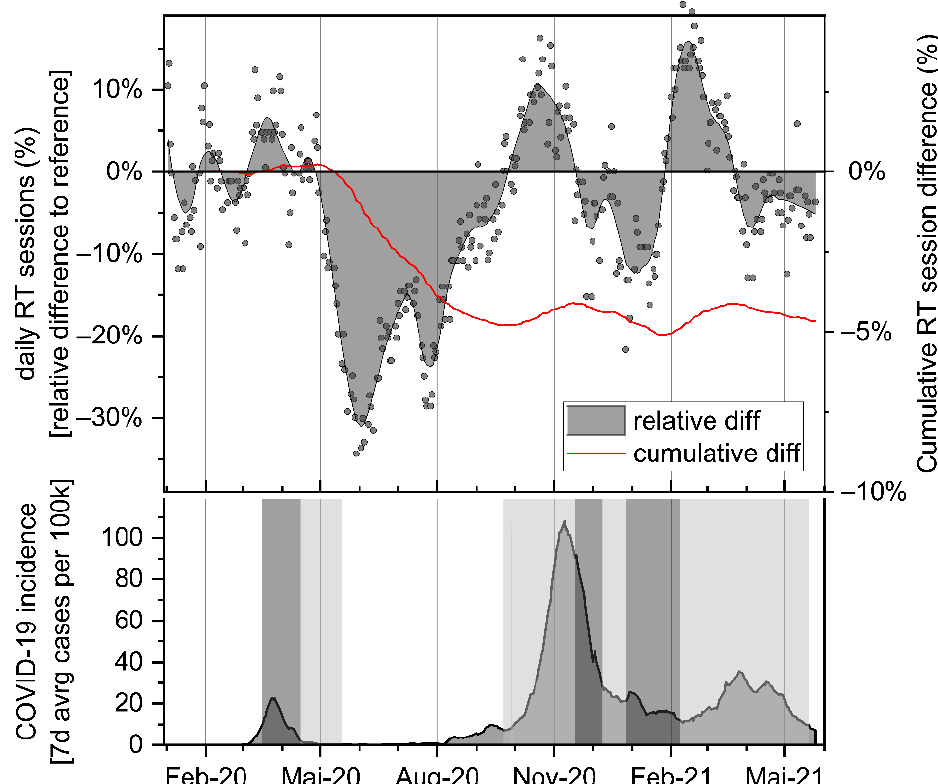
Figure 1. Upper panel: relative and cumulative difference of RT sessions performed during the pandemic period in comparison to the reference period of 2018 and 2019. Area plot: daily relative difference. Red line: Cumulative lost RT courses. COVID-19 incidence (7-day average count of confirmed new cases per 100 k people). Shaded areas indicate strict lockdown (dark grey) and moderate (light grey) national restrictions. Table 2. Loss of expected patients during the pandemic in comparison to the reference period. Percentage values depict the relative cumulative difference to the total expected number of treatment courses observed during 16 months of the progressing pandemic period (pre-pandemic reference period: February 2018 until May 2019).